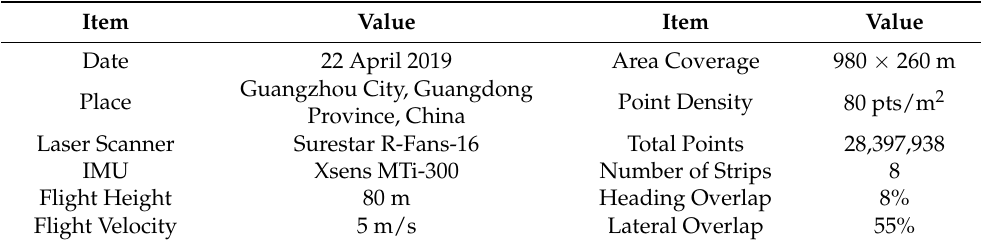
Table 2. The equipment information used to collect the experimental data, and the relevant informa- tion of strip